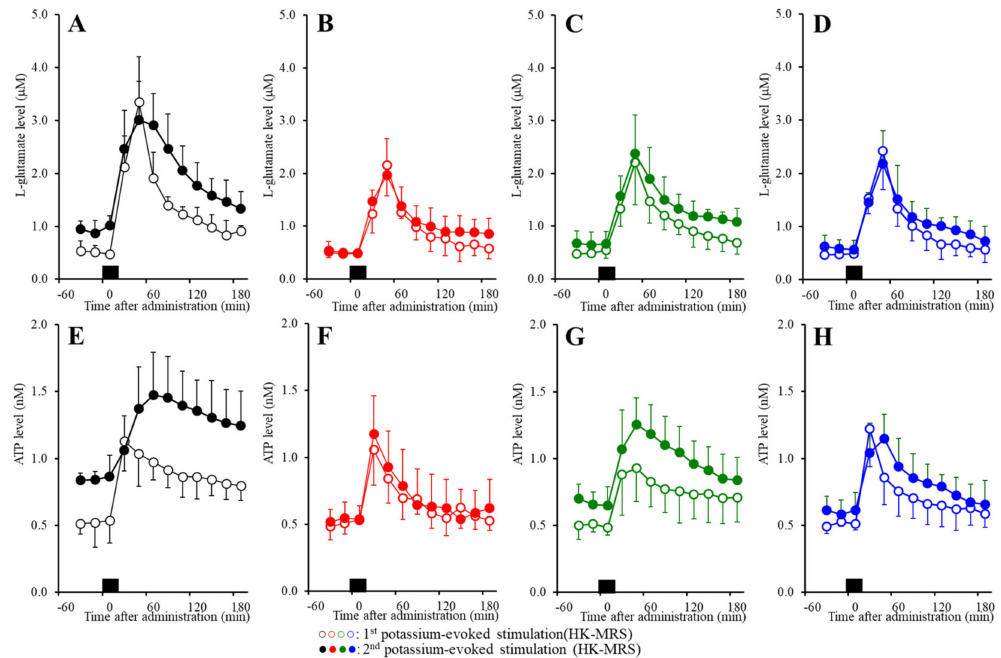
Figure 8. E ff ects of the subchronic administration of a therapeutic-relevant dose of ( B , F ) ZNS, ( C , G ) CBZ, and ( D , H ) and LCM (25 mg / kg / day for 7 days) on the repetitive K + -evoked (first stimulation: opened circles; second stimulation: closed circles) release of ( A – D ) l -glutamate and ( E – H ) ATP in the OFC. Rats were subchronically administrated with a therapeutic-relevant dose of anticonvulsants. Perfusion medium in the OFC was commenced with MRS. After the stabilization of the levels of l -glutamate and ATP in the OFC, the perfusion medium was switched from MRS to FCHK-MRS for 20 min (first stimulation). After the first K + -evoked stimulation, the perfusate was returned to MRS for 240 min (recovery). Following recovery, the perfusate was switched to FCHK-MRS for 20 min again (second stimulation). After the second FCHK-MRS stimulation, the perfusate was returned to MRS again. Ordinates: mean extracellular levels of l -glutamate ( µ M) and ATP (nM) ( n = 6); abscissas: time after the first or second FCHK-MRS stimulations (min). Black bars indicate the perfusion with FCHK-MRS (first and second K + -evoked stimulation).